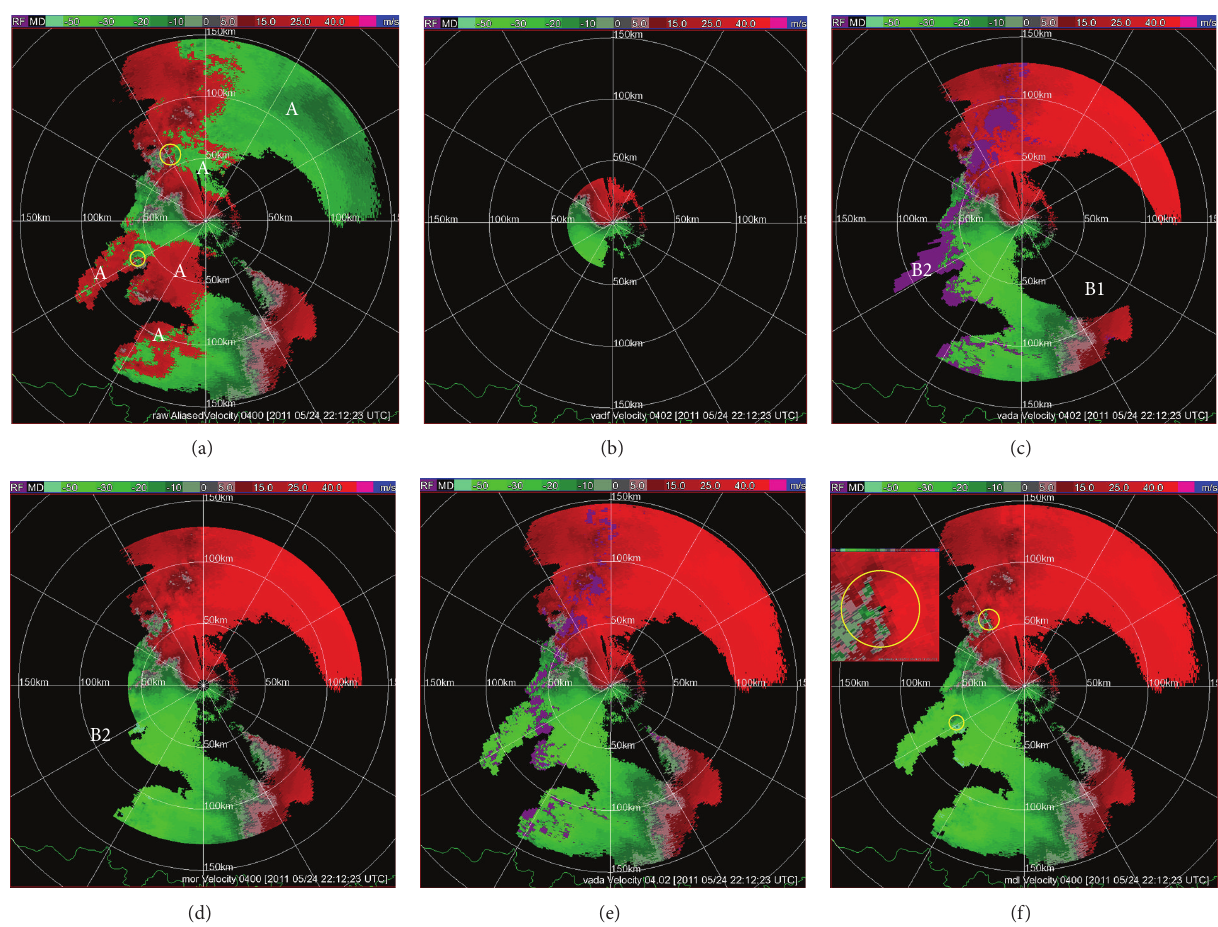
Figure 2: (a) Raw radial-velocity image scanned by the KTLX radar using VCP12 with V 𝑁 = 26.1ms −1 at 4.0 ∘ tilt for the Oklahoma tornadic storm system at 22:12:23 UTC on May 24, 2011. (b) Dealiased radial-velocity (seed data) image produced by the improved reference check alone. (c) Dealiased radial-velocity image (with the special data points plotted in purple) produced by the first one-way forward procedure in the continuity check after the improved reference check. (d) Final dealiased radial-velocity image produced by the new extended AR-Var- based method. (e) As in panel (c) but the first guess is from the RAP-predicted wind field for the refined AR-Var analysis. (f) As in panel (d) but the first guess is from the RAP-predicted wind field for the refined AR-Var analysis. The white letters “A” in panel (a) mark the main aliased-velocity areas. The white letters B1 and B2 in panel (c) mark the two flagged (in black) peninsula areas. The white letter B2 in panel (d) marks the remained flagged peninsula area. The large (or small) yellow circle marks a mature (or emerging) tornadic mesocyclone in panels (a) and (f), and a magnified frame is inserted to show the mature tornadic mesocyclone in panel (f). The green contour on the bottom of each panel shows the boundary between Oklahoma and Texas states. The color scale for the radial velocity is plotted on the top of each